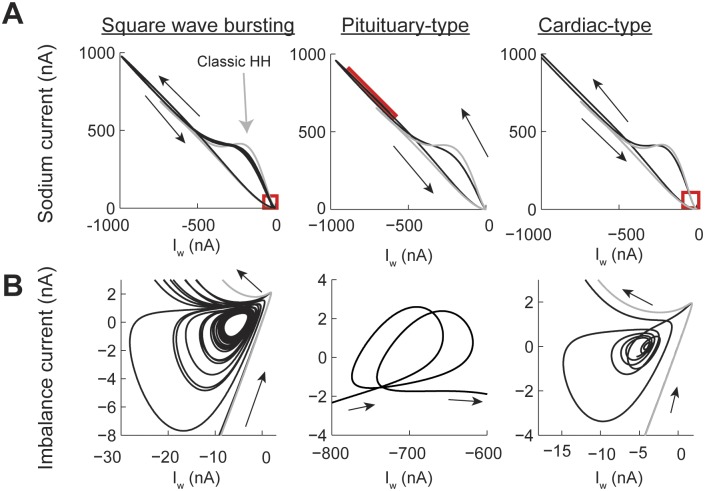
Phase plane plots of the square wave bursting and the two types of pseudo plateau potential spiking patterns in the Hodgkin-Huxley model with power-law behaving h gate.Same settings as in Fig 8. (A) Phase plot of the sodium (Ina) vs Iw = potassium + leak + injected currents, the red square shows the place of the attractor. (B) The attractors from A plotting balanced current (Ina+Iw) vs Iw.